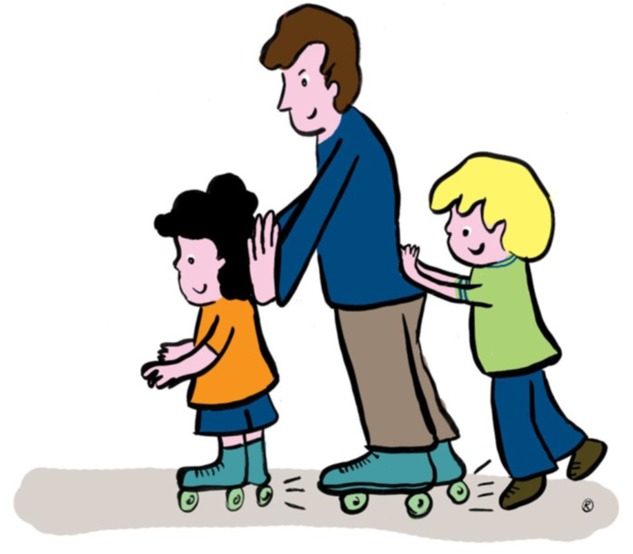
An example for a picture pair used in Experiment 2. Welcher Junge schubst den Mann? WhichNOM,MASC boy pushes theACC,MASC man? ‘Which boy is pushing the man?’